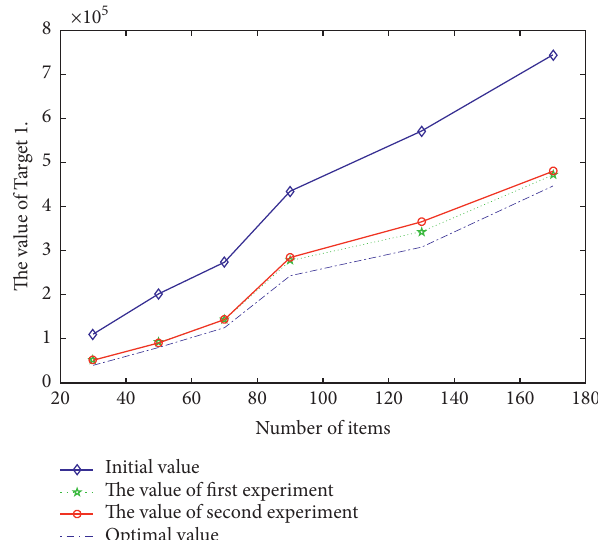
Figure 8: The comparison results of the Target function 1.